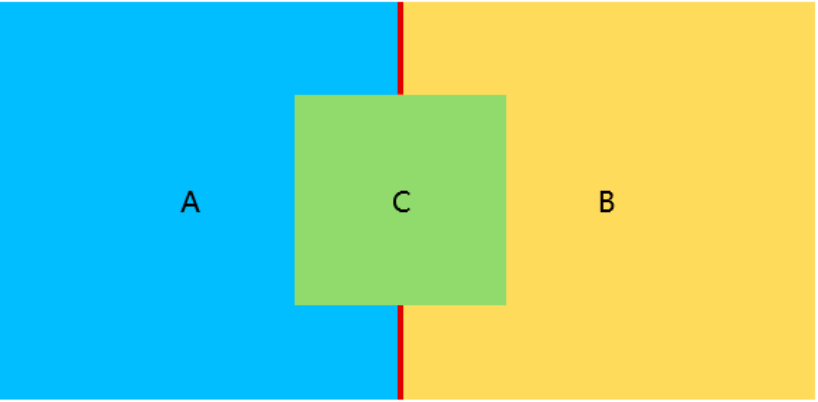
Figure 4. 2D illustration of the multi throat connection between a pore ‐ pore pair. Square A, B, and C indicate the space division after the watershed segmentation, each square is later identified as a pore cell, pore cells ‘A’ and ‘B’ shares more than one border shown as red lines, which are identified as throats.